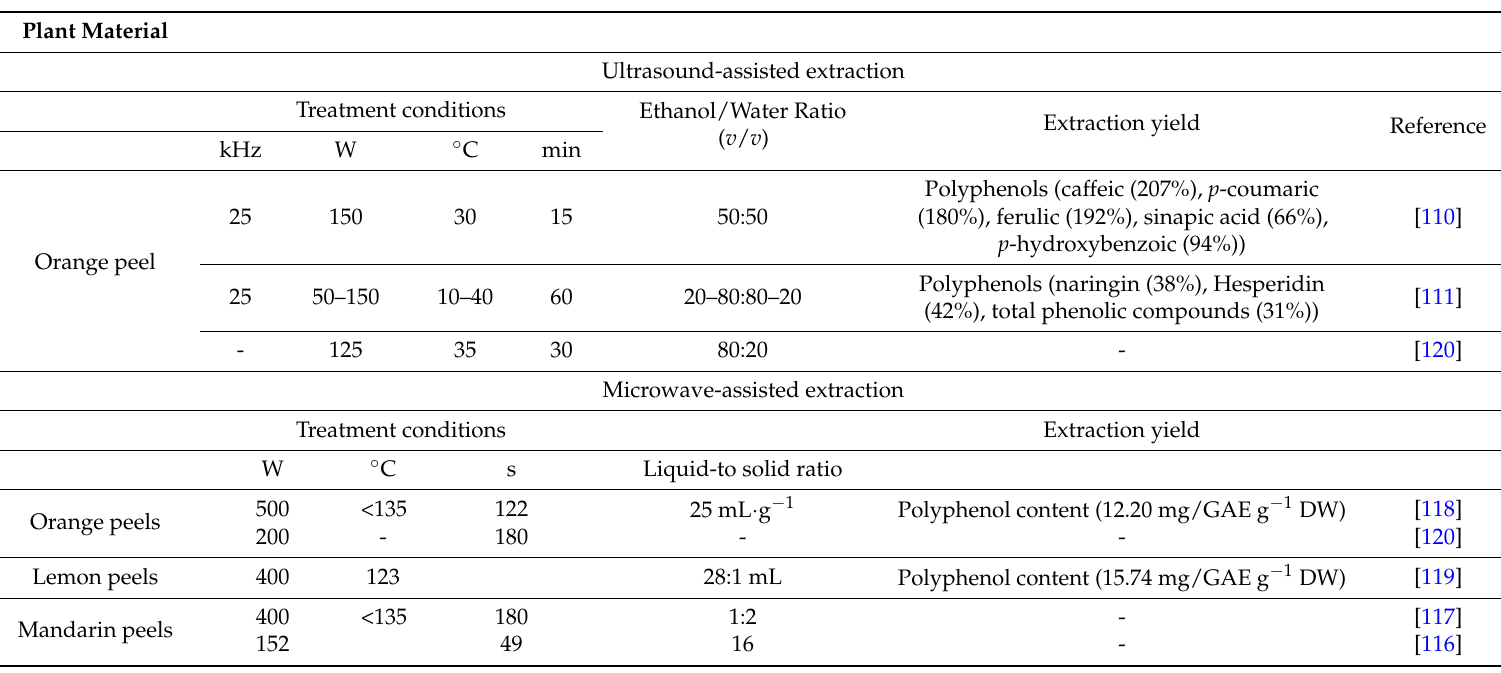
Table 3. Effect of ultrasound-assisted extraction and microwave-assisted extraction on antioxidant bioactive compound extraction from plant materials compared to conventional extraction. Adapted from Rosell ó -Soto et al.